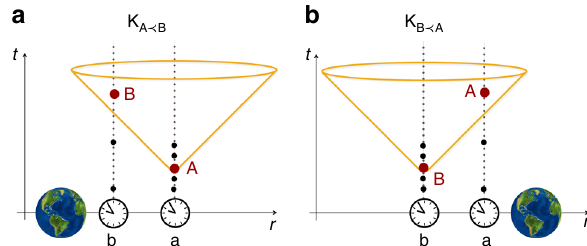
Fig. 1 General relativistic engineering of causal relations between space- time events using a massive body. Initially synchronised clocks a and b are positioned at fi xed distances from a far-away agent whose time coordinate is t . Event A (B) is de fi ned by the clock of a (b) showing proper time τ * . In con fi guration K (left) a mass is placed closer to b than to a. Due to A (cid:2) B gravitational time dilation, event A can end up in the causal past of event B: for a suf fi ciently large τ * the time difference between the clocks becomes greater than it takes light to travel between them. Light emitted at event A reaches clock b before the event B occurs. Con fi guration K (right) is B (cid:2) A fully analogous to K : the mass is placed closer to clock a and the event B A (cid:2) B can end up in the causal past of the